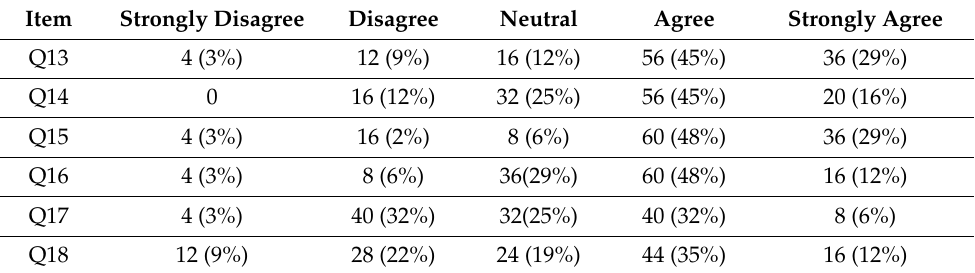
Table 13. Frequency distribution table for items regarding the effects of emotional messages.